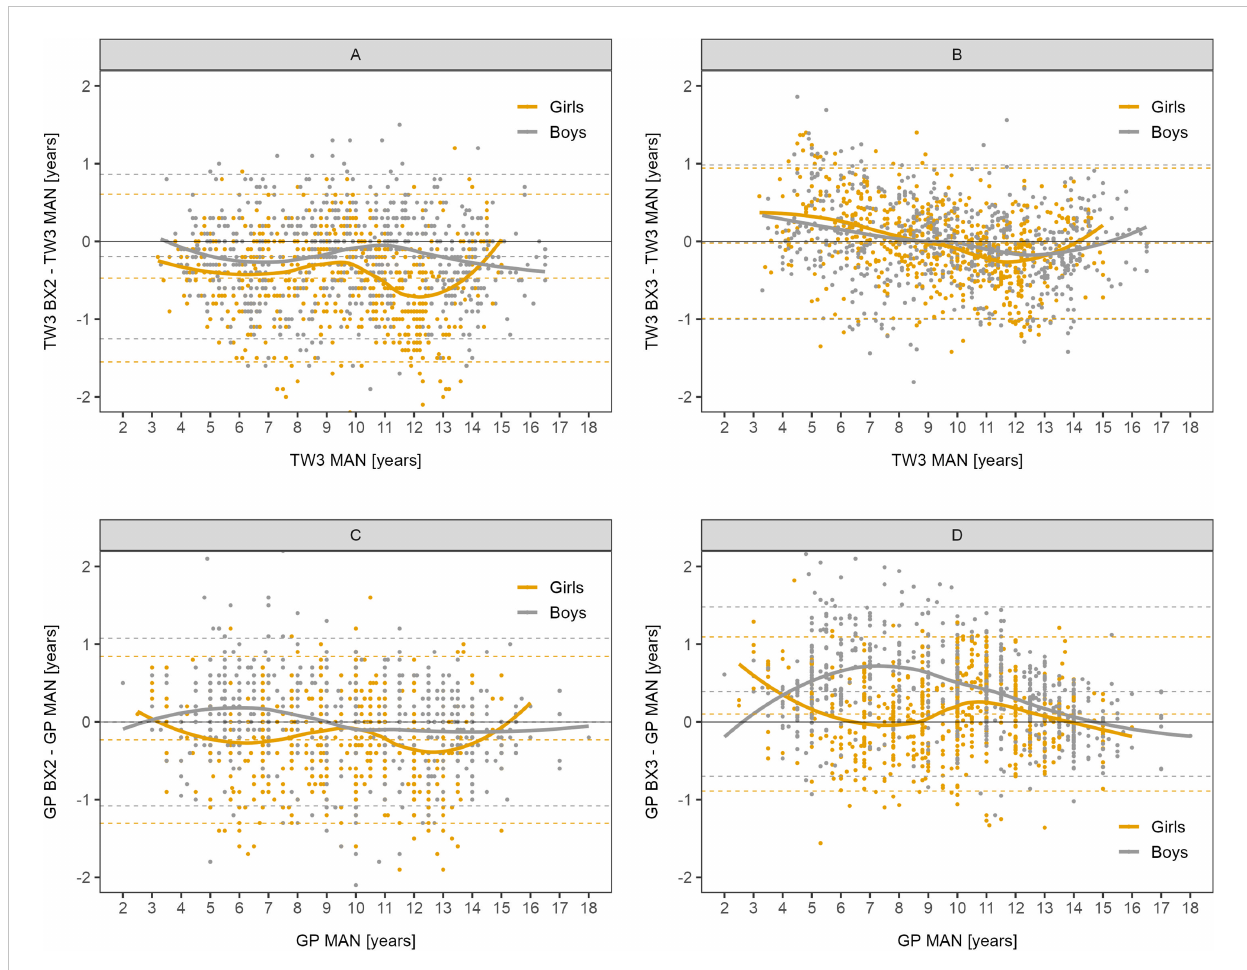
FIGURE 1 Bland-Altman analysis – difference in years between automated and manual bone age result plotted against the manual bone age values. Sex- speci fi c smoothing lines computed by LOESS method. Bland-Altman analysis shows whether there is a systematic component to the differences between methods. Dashed lines show mean and upper and lower limit of accuracy for respective methods and sex. The closer the mean to 0 the less over/underestimating the method is, overall. (A) TW3, BX2 vs. manual, (B) TW3, BX3 vs. manual, (C) GP, BX2 vs. manual, (D) GP, BX3 vs. manual. TW3, bone age assessment according to Tanner-Whitehouse 3 method; GP, bone age assessment according to Greulich-Pyle method; BX2, BoneXpert version 2.4.5.1.; BX3, BoneXpert version 3.0.3.; MAN, manual bone age assessment.